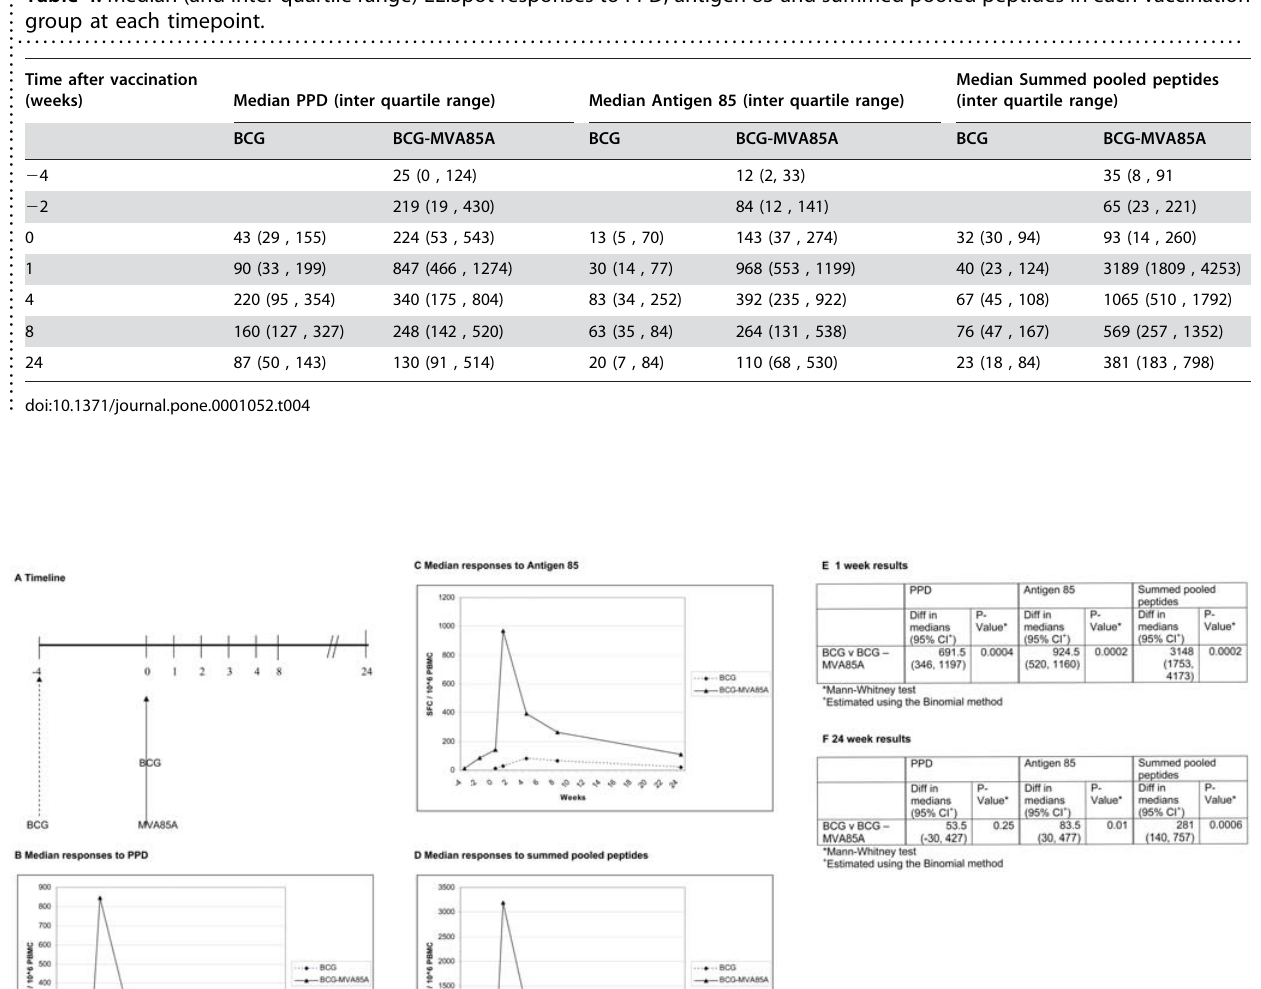
Table 5. Area under the curve analysis for BCG alone and BCG–MVA85A groups .. ... .... ... ... .... ... ... .... ... ... .... ... ... .... ... ... .... ... ... .... ... ... .... ... ... .... ... ... .... ... ... .... ... ... .... ... ... .... ... ... .... ... ... . Vaccine group n Median AUC (25 th , 75 th percentiles) PPD Antigen 85 Summed pooled peptides